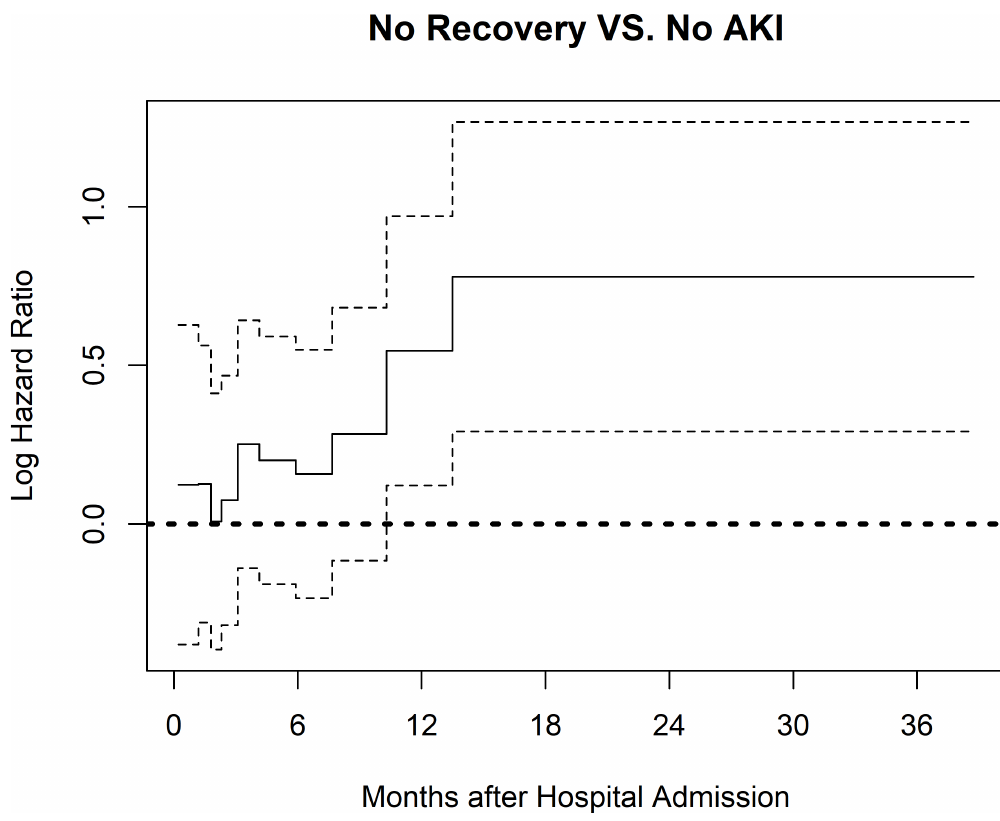
Fig 3. Time-varying covariate effects with 95% confidence intervals of renal recovery at hospital discharge in Gray’s model. Hazard ratios (HR) of Non-recovery vs No AKI from the Gray’s model are reported as the minimum to maximum covariate effect during 10 time intervals. AKI: Acute kidney injury; PSI: Pneumonia Severity Index (on day 1, without age).